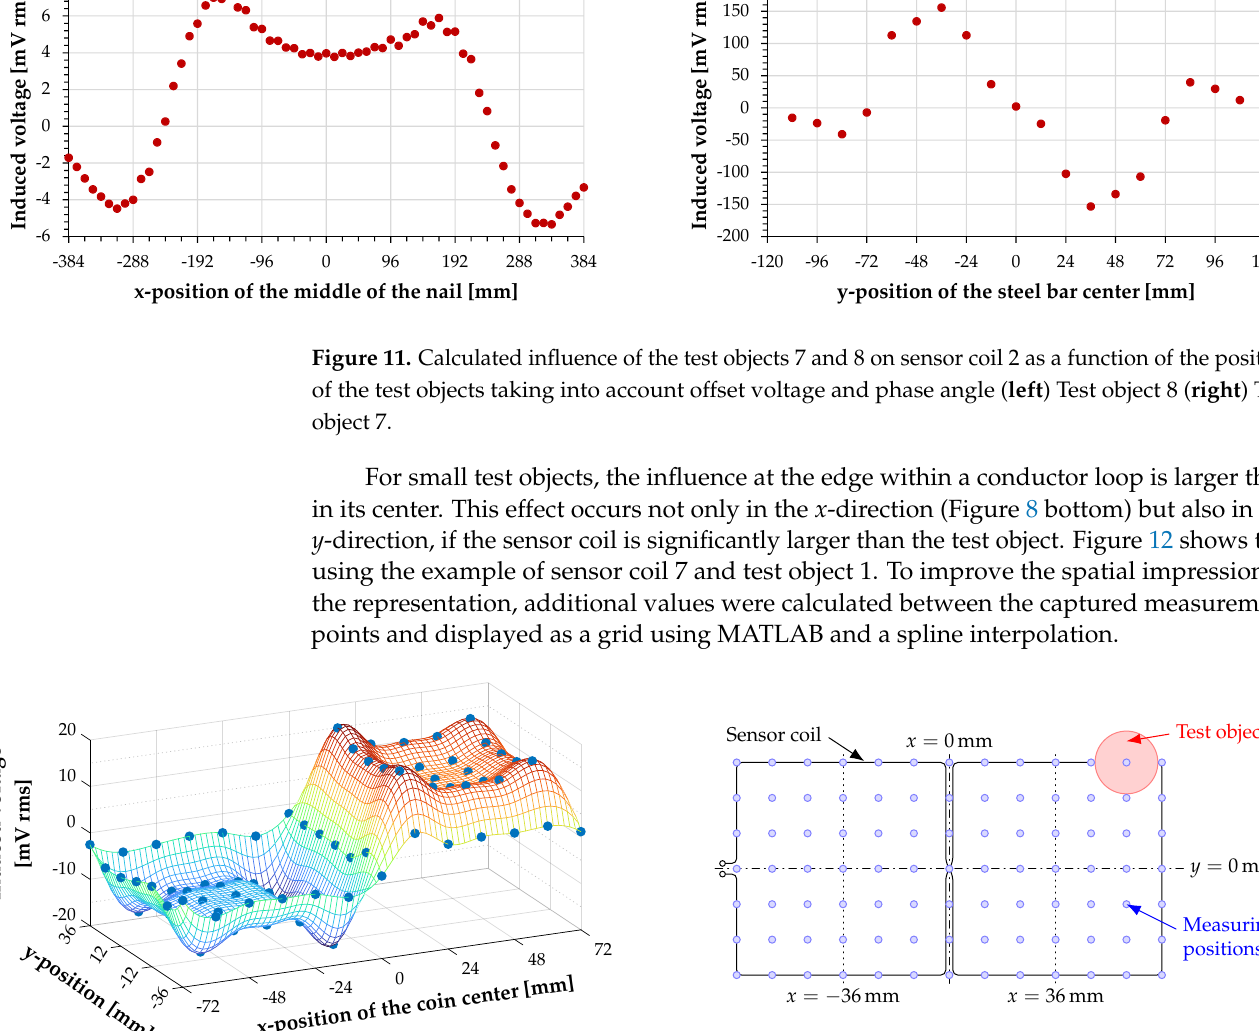
Figure 12. Output voltage of sensor coil 7 with test object 1 ( left ) Position-dependent influence of the 0.05 e coin ( right ) Schematic of the measuring positions (center of the coin) and the relative size of sensor coil and test